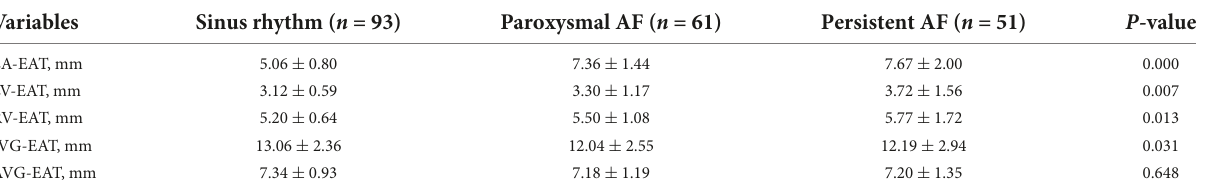
TABLE 4 Redistribution of EAT in different regions of the heart in patients with AF.